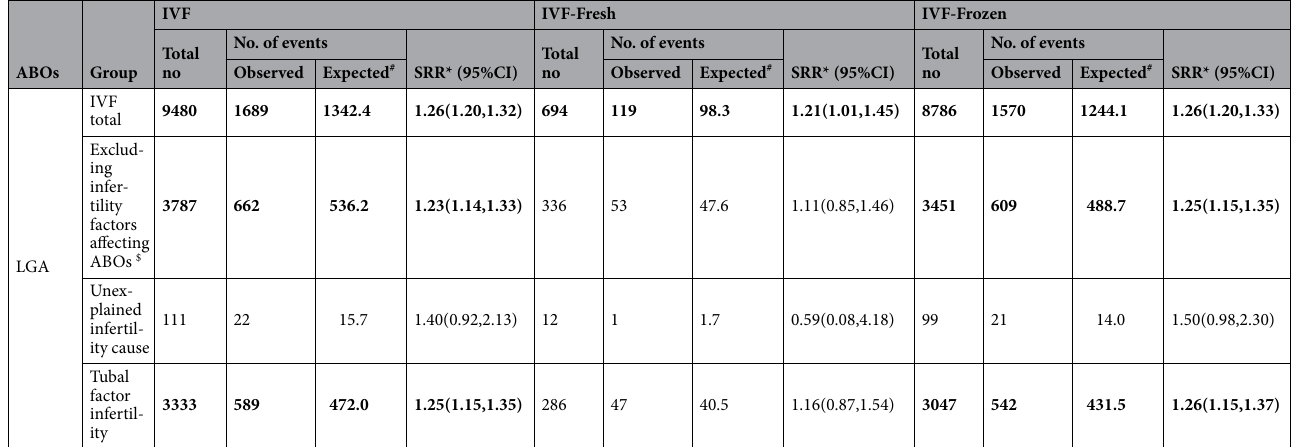
Table 3. Observed and expected cases of adverse birth outcomes among infants conceived with IVF in mothers with normal BMI. # The number of expected cases was calculated by applying the rates of PTB, LBW, macrosomia, SGA and LGA from the birth registry data to the population of infants conceived with assisted reproductive technology. The values were adjusted to account for differences in the distributions of year of birth, maternal age, infant sex and parity between the two populations. * SRR standardized risk ratio. $ Infertility factors affecting ABOs meant infertility factors that influenced the birth outcomes, including semen abnormalities, endometriosis, polycystic ovary syndrome and uterine factor infertility. Statistical differences are shown in